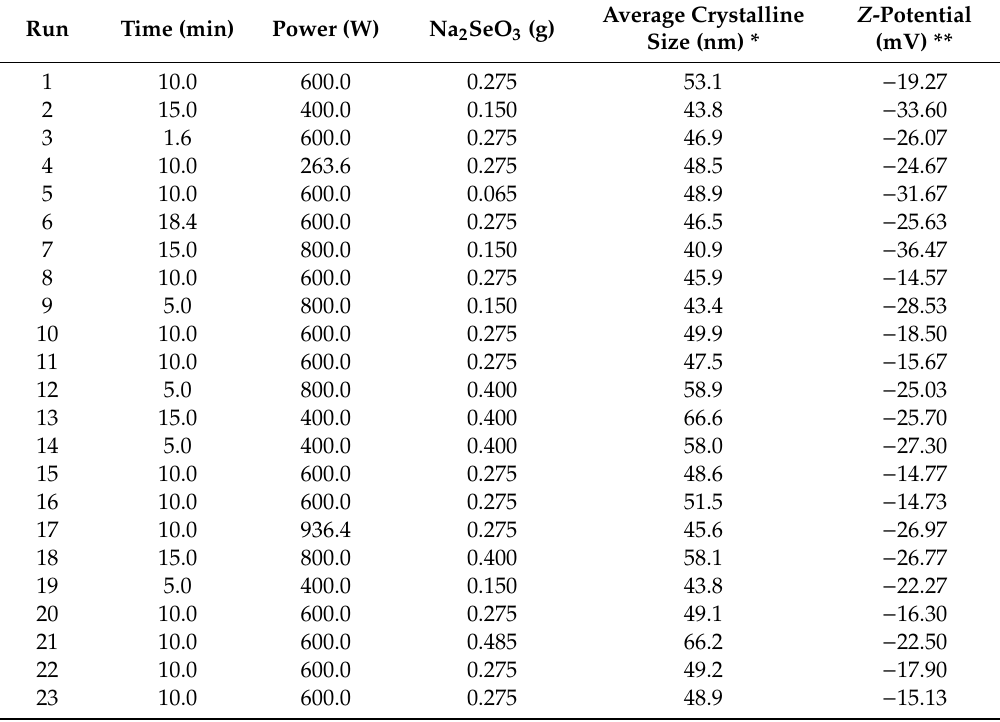
Table 2. Central composite design matrix and response values obtained for the synthesis of